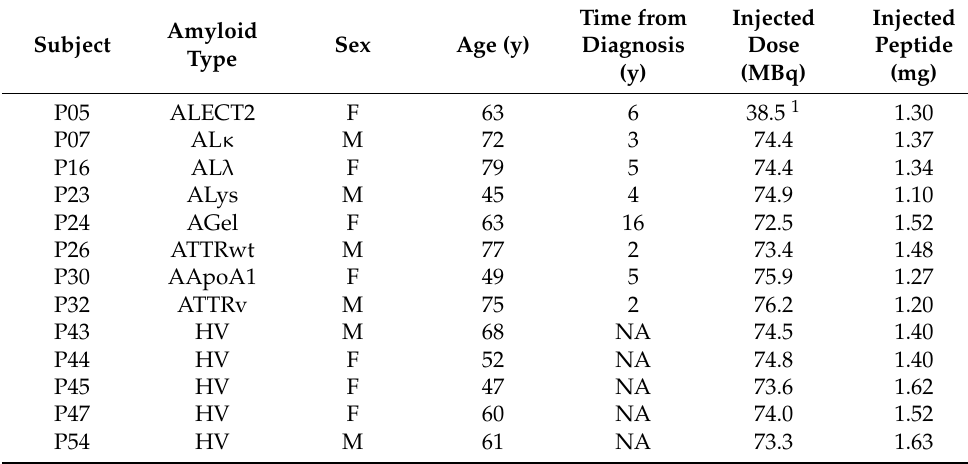
Table 1. Patient cohort and healthy subject characteristics with dose